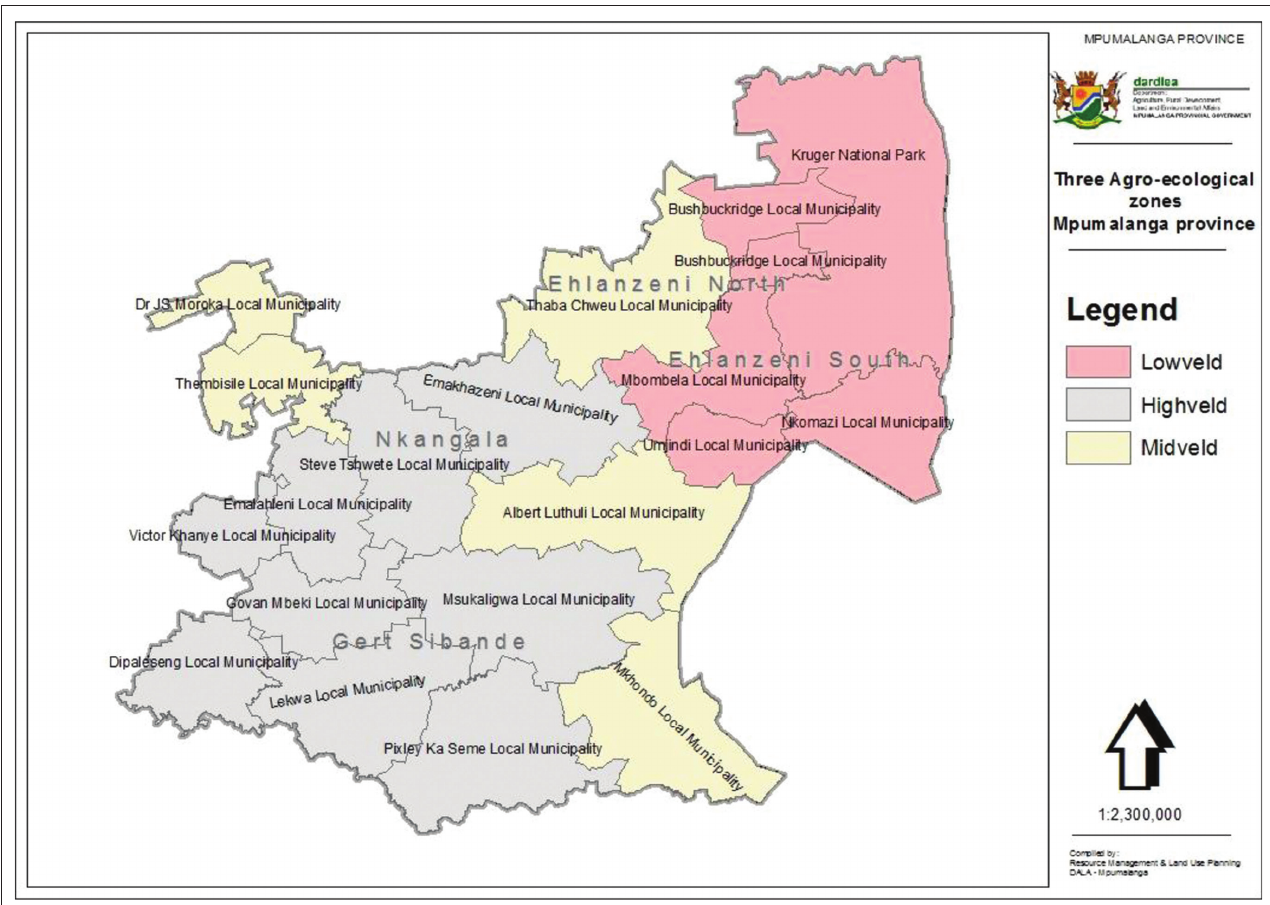
FIGURE 1: Map of Mpumalanga with demarcation of agro-ecological